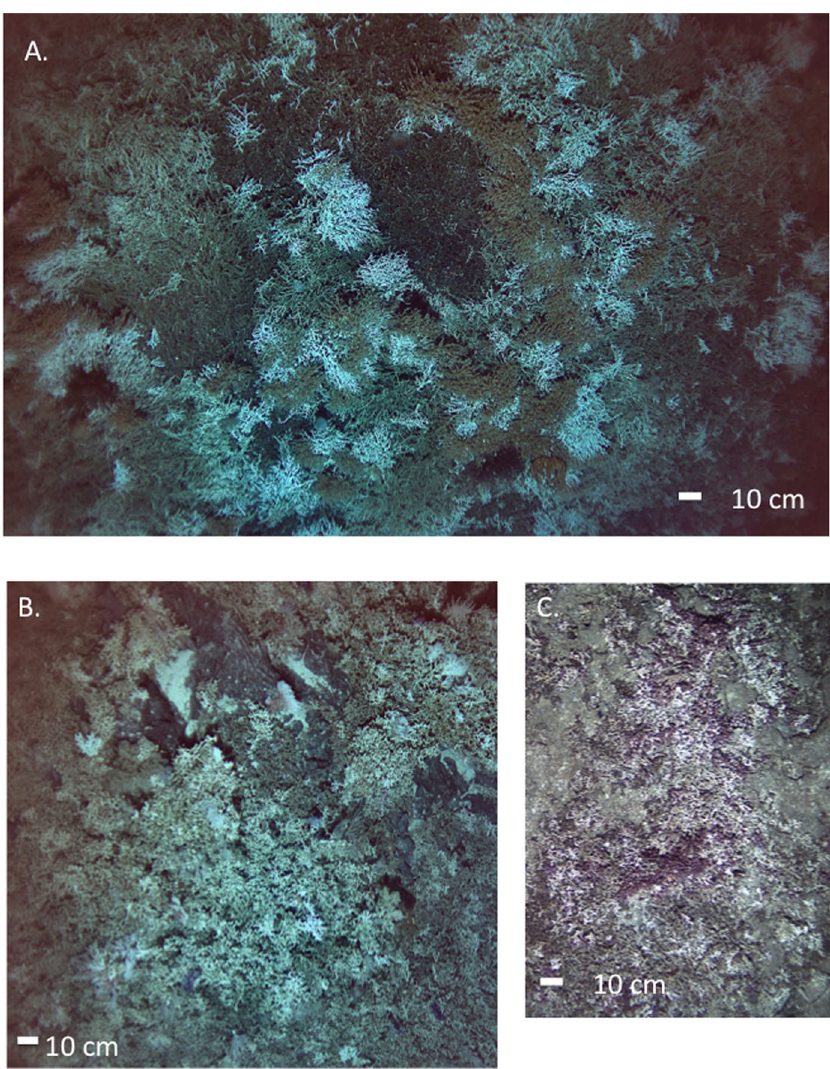
Figure 2. Example AUV images of observed scleractinian reefs taken ~5 m above the bottom. The reef at ( A ). 641 m on Northwest Hancock and ( B ) 637 m on Southeast Hancock, were predominantly a species with orange polyps, most likely Solenosmilia . ( C ) The purple scleractinian reef, most likely formed by Enalopsammia , at 596 m on Yuryaku. Images obtained by the authors using the AUV